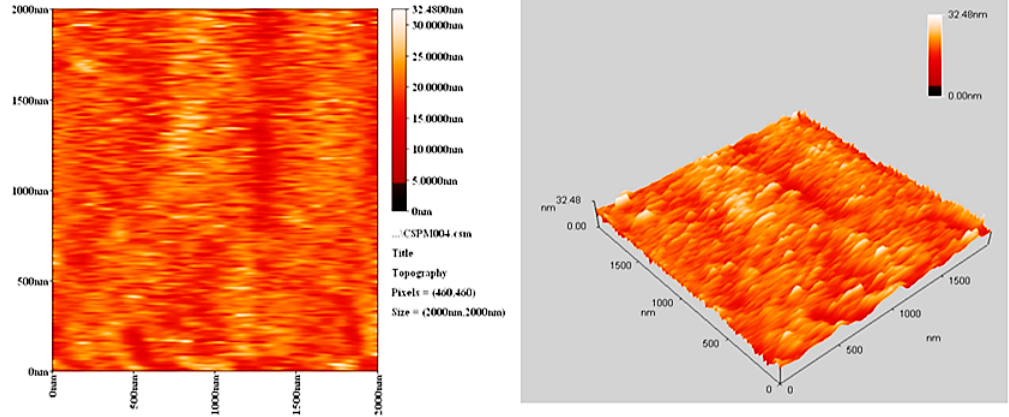
Figure 11. AFM images for PVC film containing Ph 3 SnL complex after irradiation (300 h).